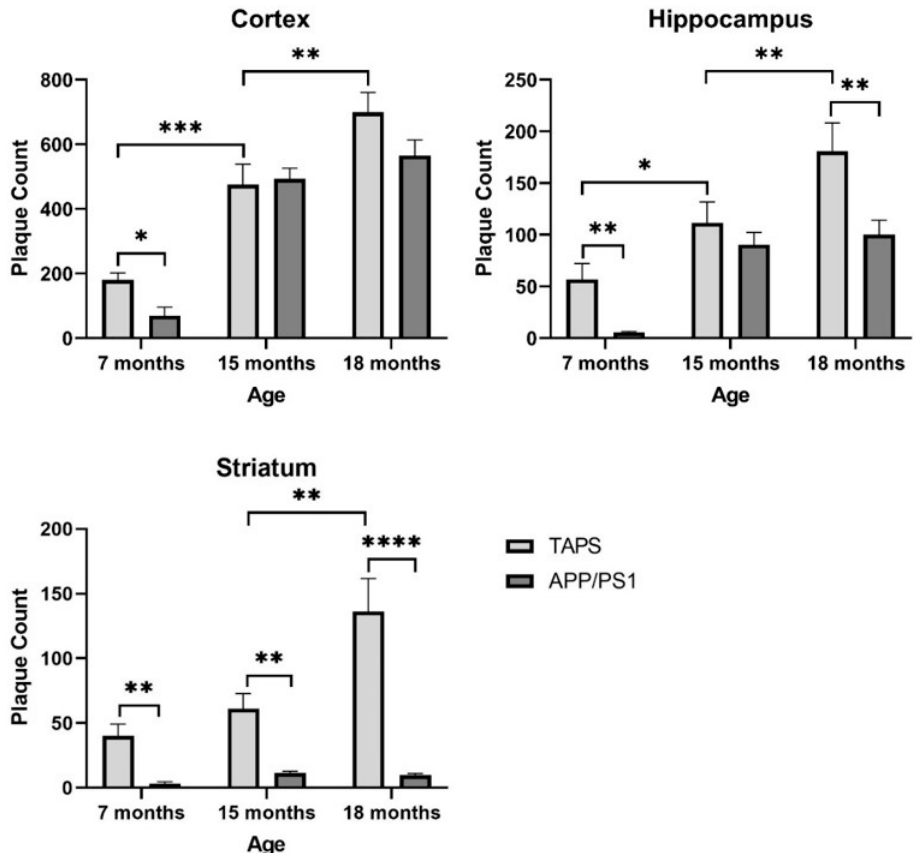
Figure 4. Plaque quantification in the brain of TAPS and APP/PS1 mice. The number of plaques was quantified on brain sections after immunostaining against total A β . TAPS mice showed an earlier onset in plaque formation in all investigated areas than APP/PS1 and a stronger progression until the age of 18 months. For statistical analysis, a two-way ANOVA was used to compare the age related, as well as a multiple t -test to analyze for genotype-dependent differences. Total number of animals was TAPS ( n = 16), APP/PS1 ( n = 15). For exact animal numbers per age, see Table 1. Data are given as mean + SEM; * p < 0.05; ** p < 0.01; *** p < 0.001; **** p < 0.0001.